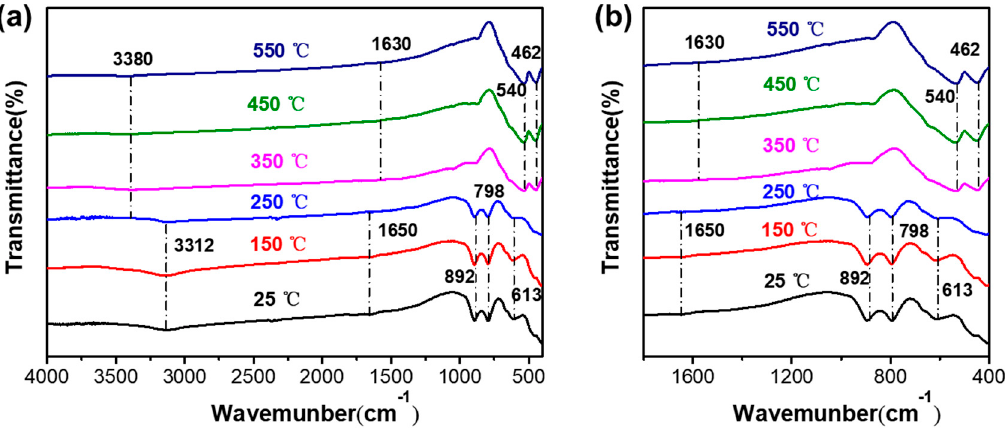
Figure 2. The FT-IR spectroscopy of pristine goethite and the calcined products of goethite at different temperatures for 1 h. ( a ) all spectrum, ( b ) regions of 1800 - 450 cm − 1 .